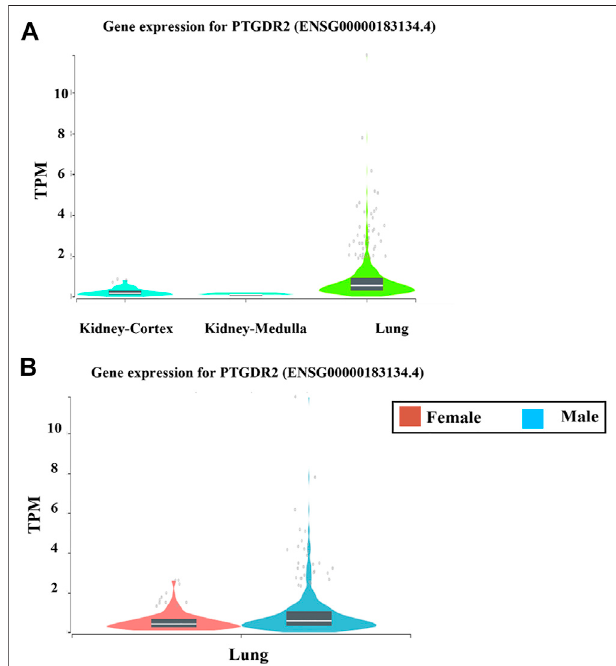
FIGURE 5 | The mRNA expression levels of PTGDR2 in lung and kidney tissues using The Genotype-Tissue Expression (GTEx) project (www. gtexportal.org) portal Cellular localization of the differentially identi fi ed gene